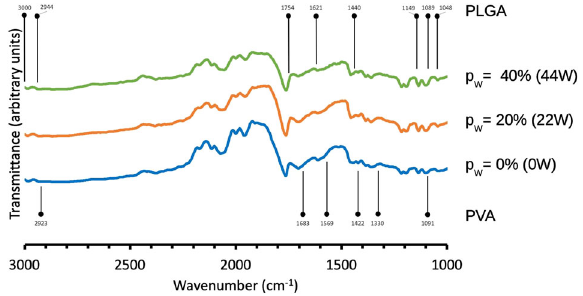
Fig. 4 Fourier transform infrared spectra of PLGA/PVA scaffold treated to the respective sonication power levels, 0, 20 ( p W ), and 40% ( p W ), at 5 min soaking duration. Of note, PVA and PLGA have linear formula given by (CH 2 CH(OH)) n and (C 3 H 4 O 2 ) x (C 2 H 2 O 2 ) y respectively Table 1 Summary of band frequencies corresponding to PVA and PLGA, derived from FT-IR of PLGA/PVA